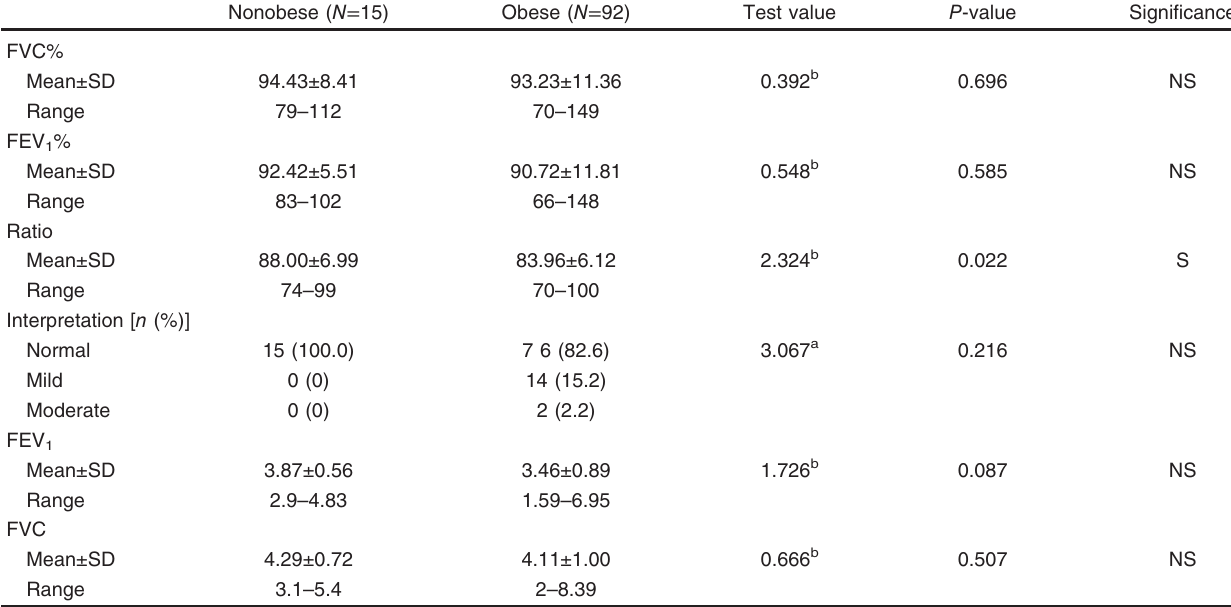
Table 5 Comparison between obese and nonobese as regard spirometric indices Nonobese ( N = 15) Obese ( N = 92) Test value P -value